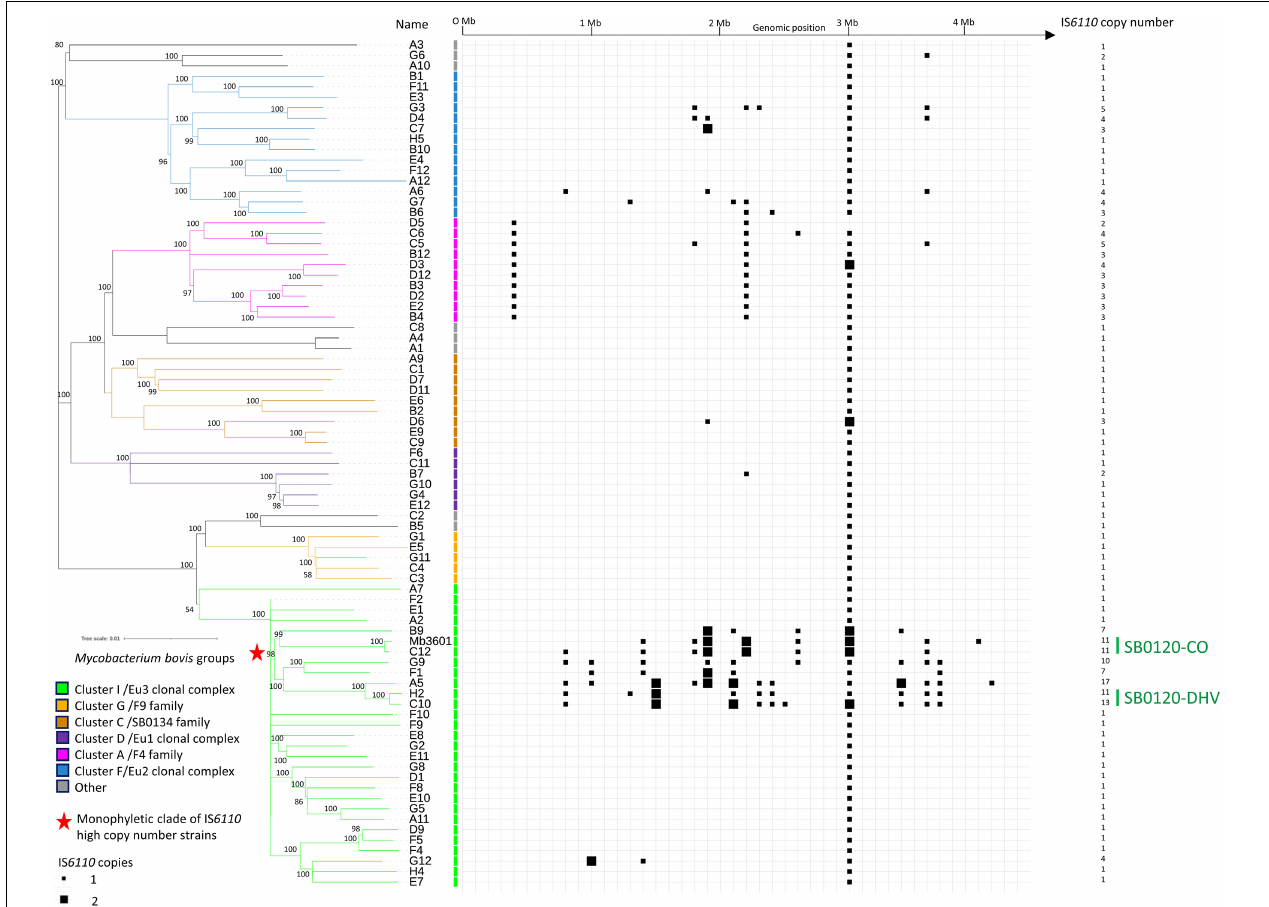
FIGURE 1 | IS 6110 occurrence in Mycobacterium bovis French genetic diversity. Heatmap showing the presence and genomic position of IS 6110 in 81 genomes (80 genomes of Mycobacterium bovis representing French diversity and Mb3601 reference strains). The tree is based on 8,981 whole-genome single nucleotide polymorphism. The strains are grouped in 7 clusters that have been previously defined (Hauer et al., 2019).